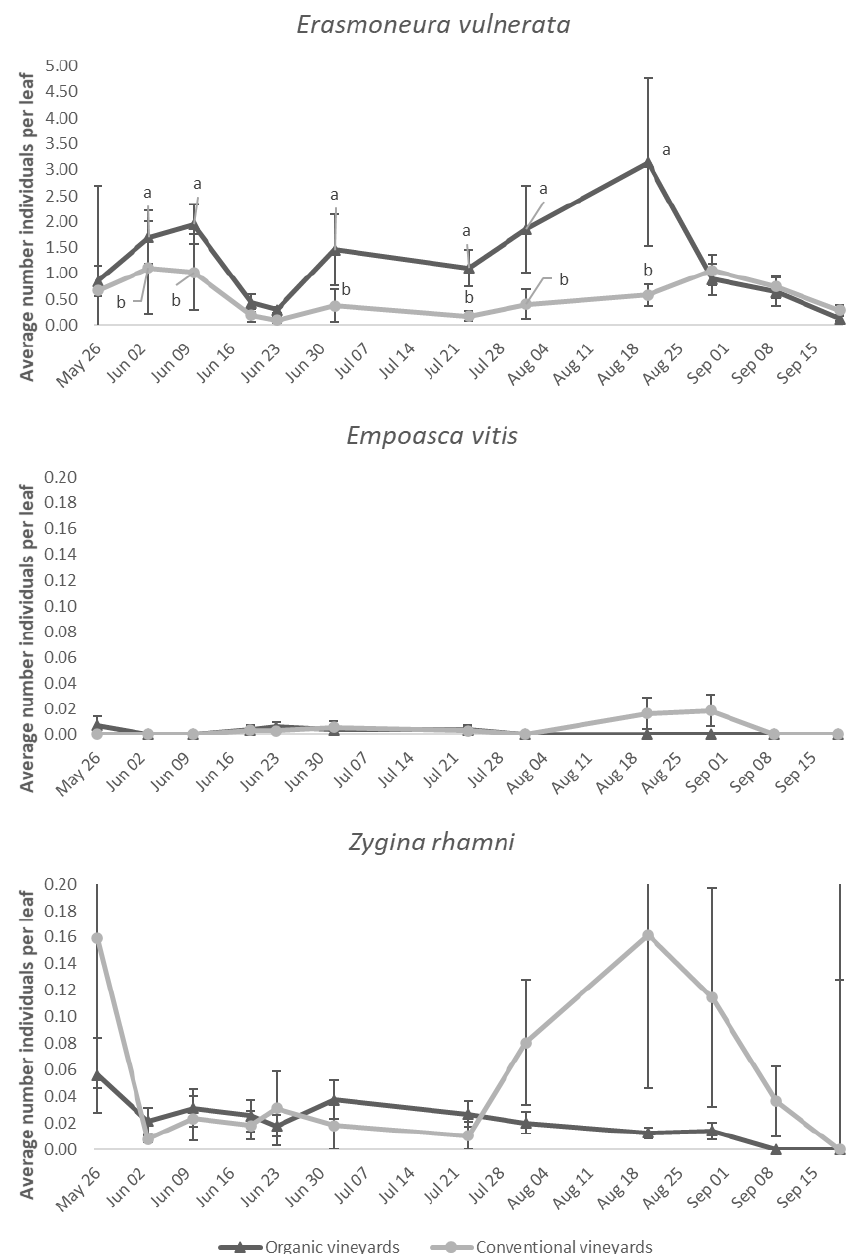
Figure 12. Mean (± std. err.) number of E. vulnerata , E. vitis and Z. rhamni nymphs observed on leaves collected in organic and conventional vineyards. Different letters indicate significant differences at Tukey’s test on least square means ( α = 0.05) of the number of nymphs observed on each date. Higher parasitism rates from Mymarids were found in organic vineyards (mean 42%) compared to conventional vineyards (mean 23%) (F = 7.08; d.f. = 1; 19.8; p = 0.015). In organic vineyards, the highest parasitism rates were observed in late spring (55.5%) and late summer (54%). The effect of time was significant (F = 2.57; d.f. = 7, 66.1; p = 0.021), while the interaction vineyard management * time was not (F = 1.13; d.f. = 7, 66.1; p = 0.358). This is likely due to the decline in parasitism rates during mid-summer in both situations.